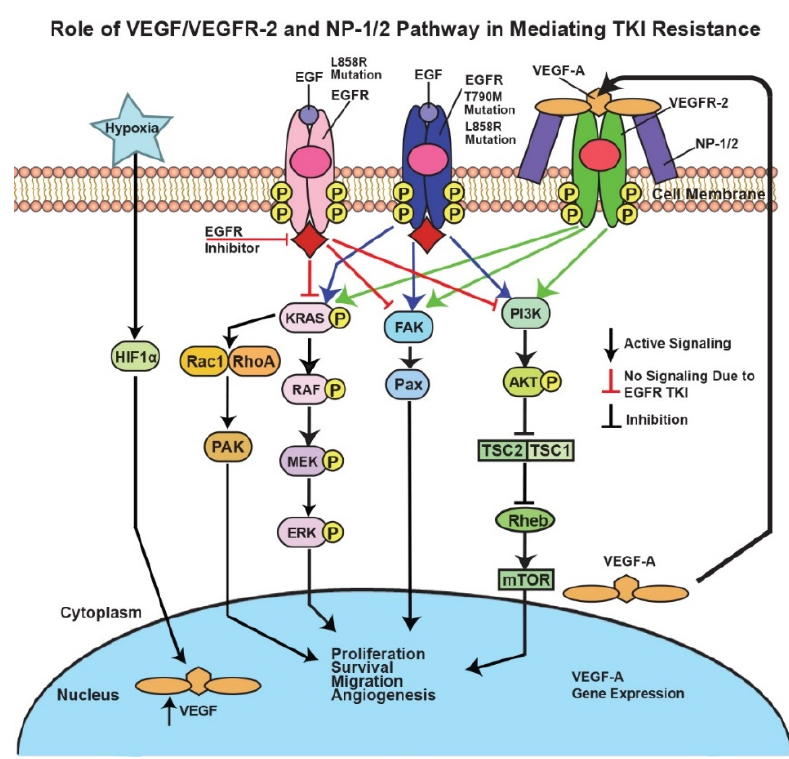
Figure 9. Mechanisms of resistance to molecularly targeted therapy in NSCLC . In TKI-resistant NSCLC cells activated EGFR leads to activation of the MAPK, FAK-Paxillin, and PI3K-AKT-mTOR downstream pathways, resulting in increased proliferation, survival, migration, and angiogenesis. EGFR TKIs inhibit this activation; however, due to mutations (primary L858R and secondary T790M mutations), tumor cells acquire resistance against these TKIs, activating these pathways further.